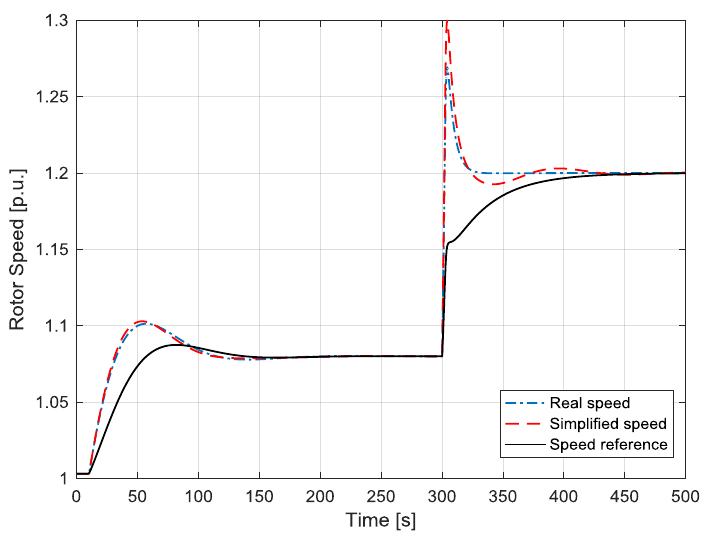
Figure 18. Rotor speed time profile.